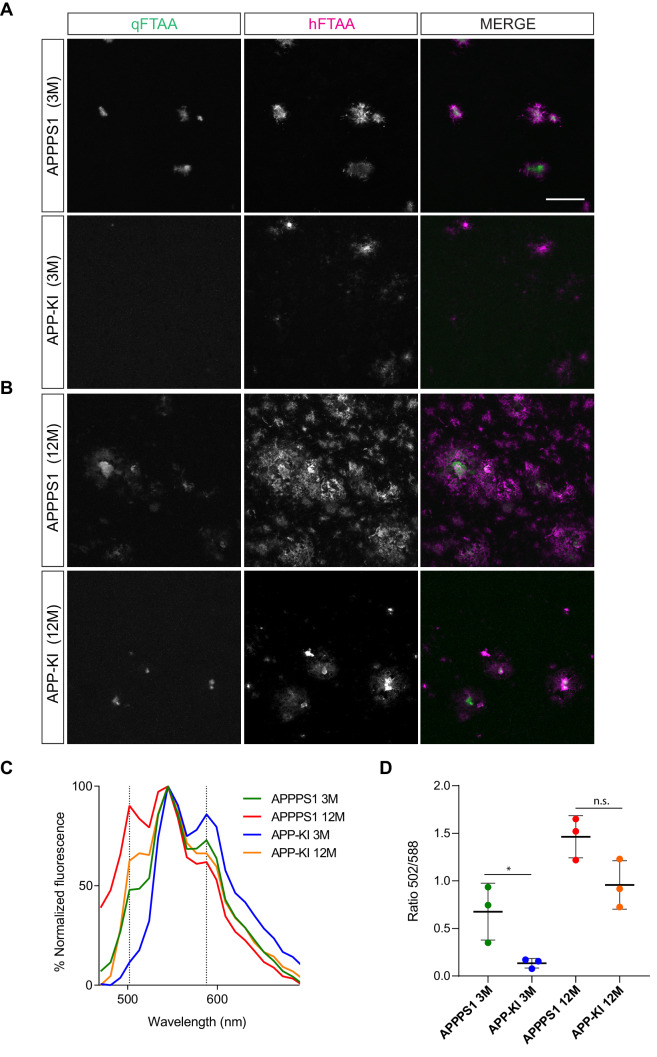
Amyloid plaque spectral characteristics show differences between 3 month old APPPS1 and APP-KI mice.Representative images of LCOs (qFTAA in green and hFTAA in magenta) in 3 (A) and 12 month old (B) APPPS1 and APP-KI mice. Scale bar: 50 µm. (C) Mean LCOs fluorescence spectra of plaque cores in both mouse models at 3 and 12 months. (D) Quantification of the mean ratio of the fluorescence intensity at 502 nm and 588 nm (fluorescence emission peaks of qFTAA and hFTAA, respectively). Individual values from N = 3 mice per age and genotype ± SD are represented (*p<0.05; unpaired two-tailed Student’s T-test; n.s.: not significant).